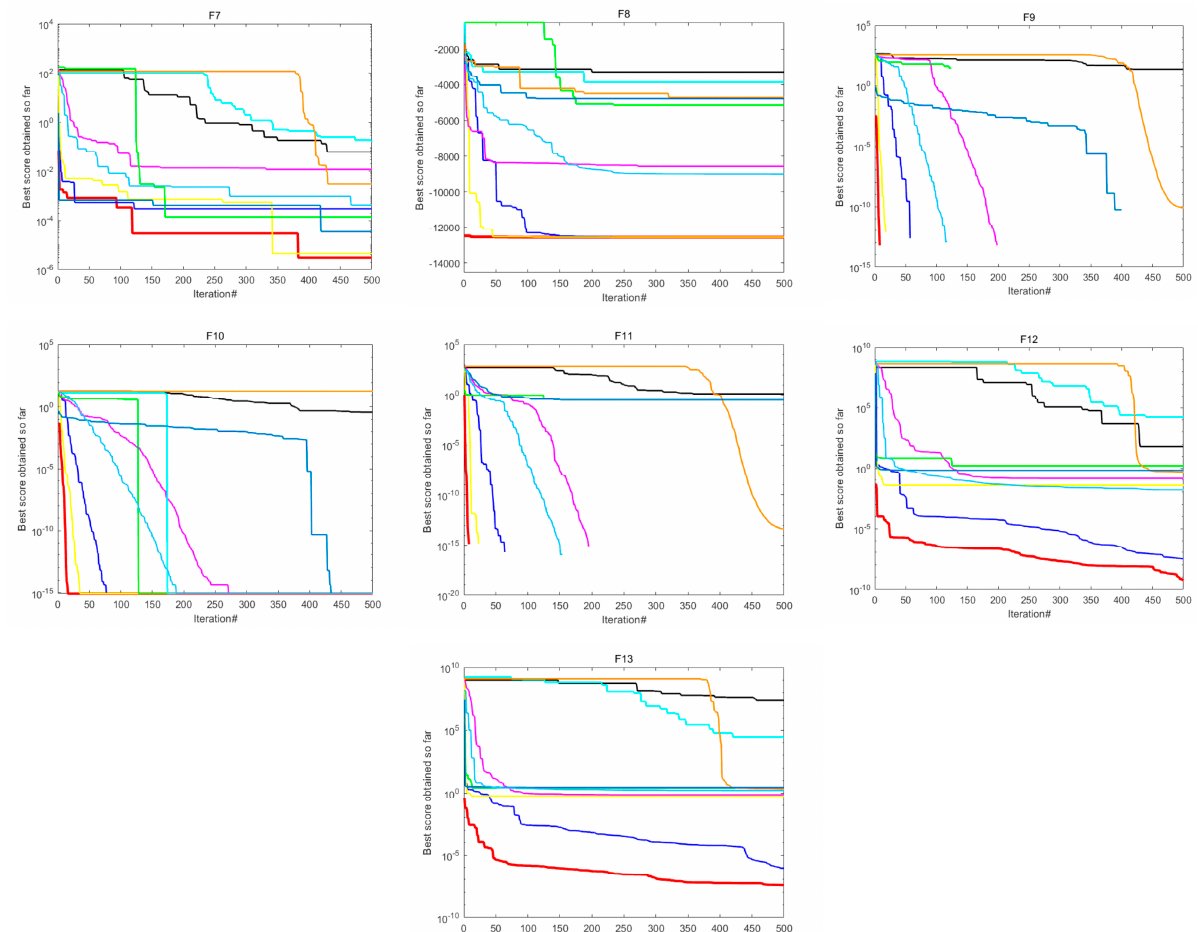
Figure 3. Convergence curves for the optimization algorithms for standard benchmark functions (F1–F13) with dim = 30.